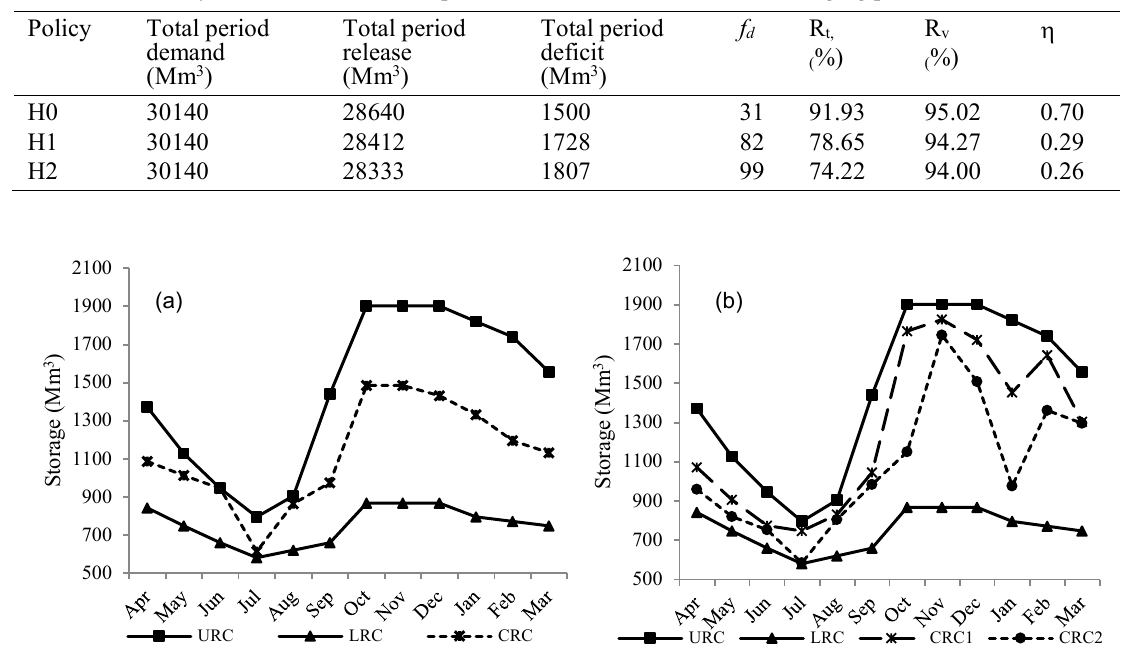
Table 2 Summary of evaluated reservoir performance indices for the tested hedging policies.